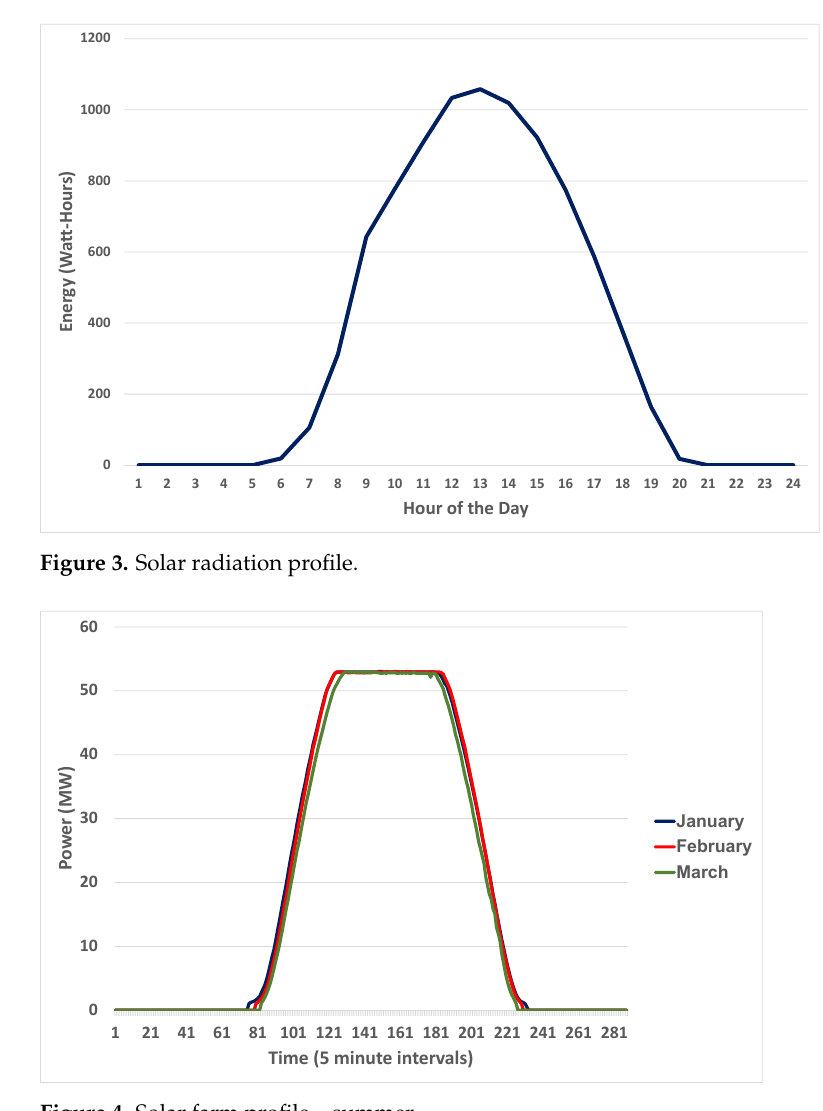
Figure 4. Solar farm